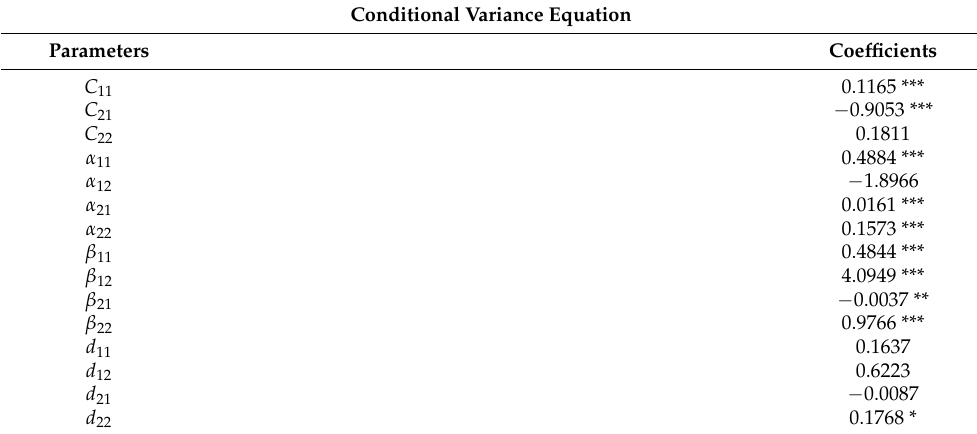
Table 4. Volatility spillover between the bond ( r Bond ) and dollar-funded carry trade ( r CT/Dollar )